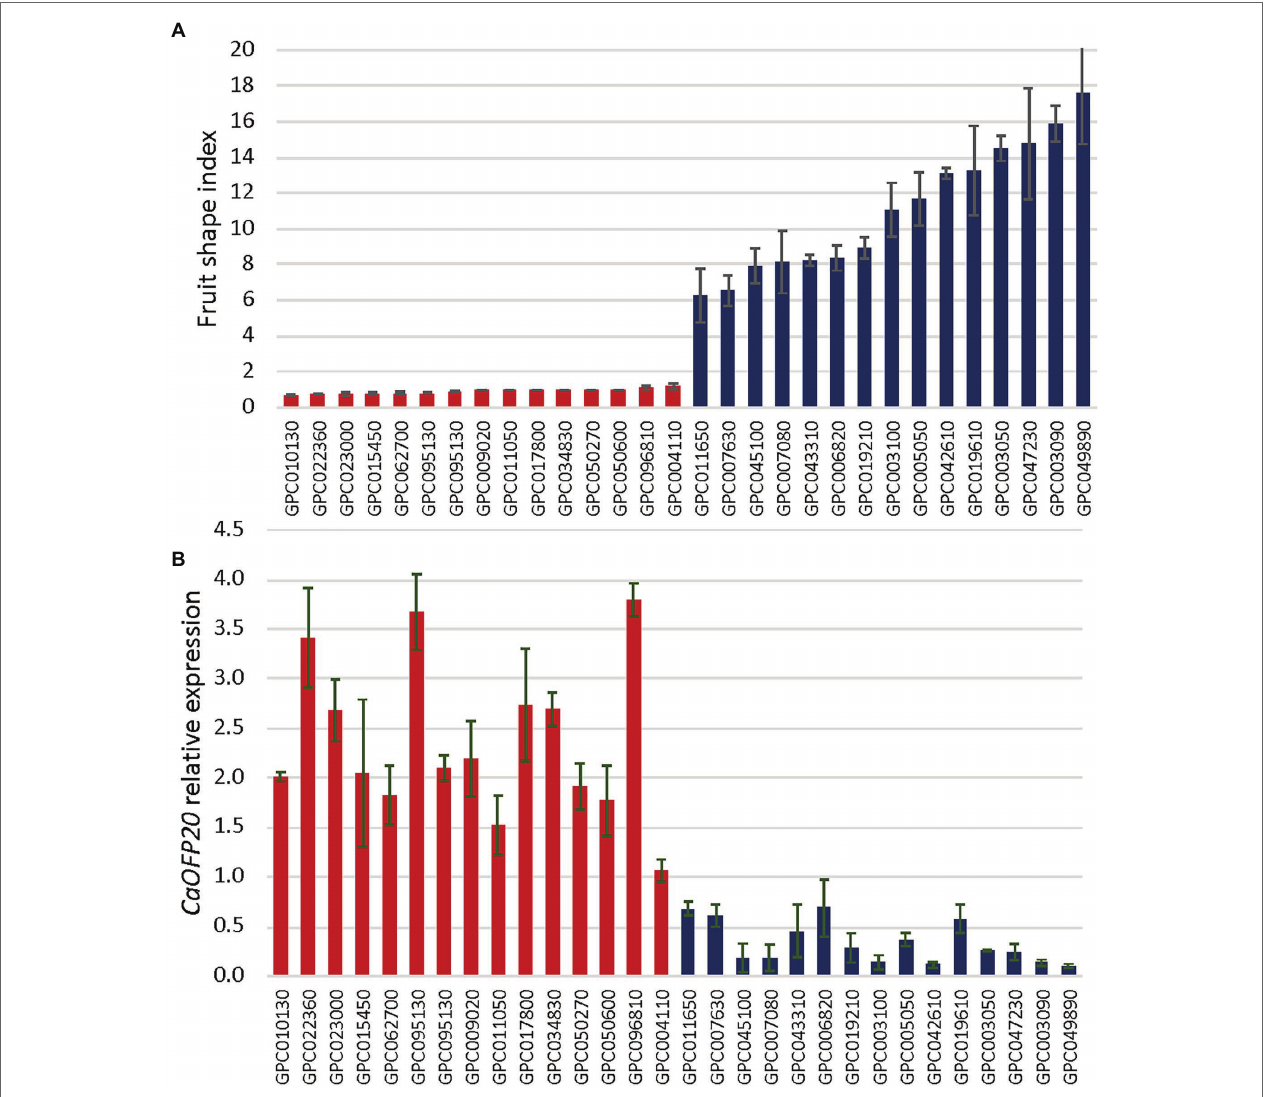
FIGURE 7 | Fruit shape index is associated with expression level of CaOFP20 in a panel of round- and elongated-fruited accessions. (A) Ripe fruit shape index of accessions in the panel. (B) Expression of CaOFP20 in fruit pericarp 3 weeks after anthesis. Error bars represent standard deviation of three fruit per accession. Columns of round- and elongated-fruited accessions are colored in red and blue,